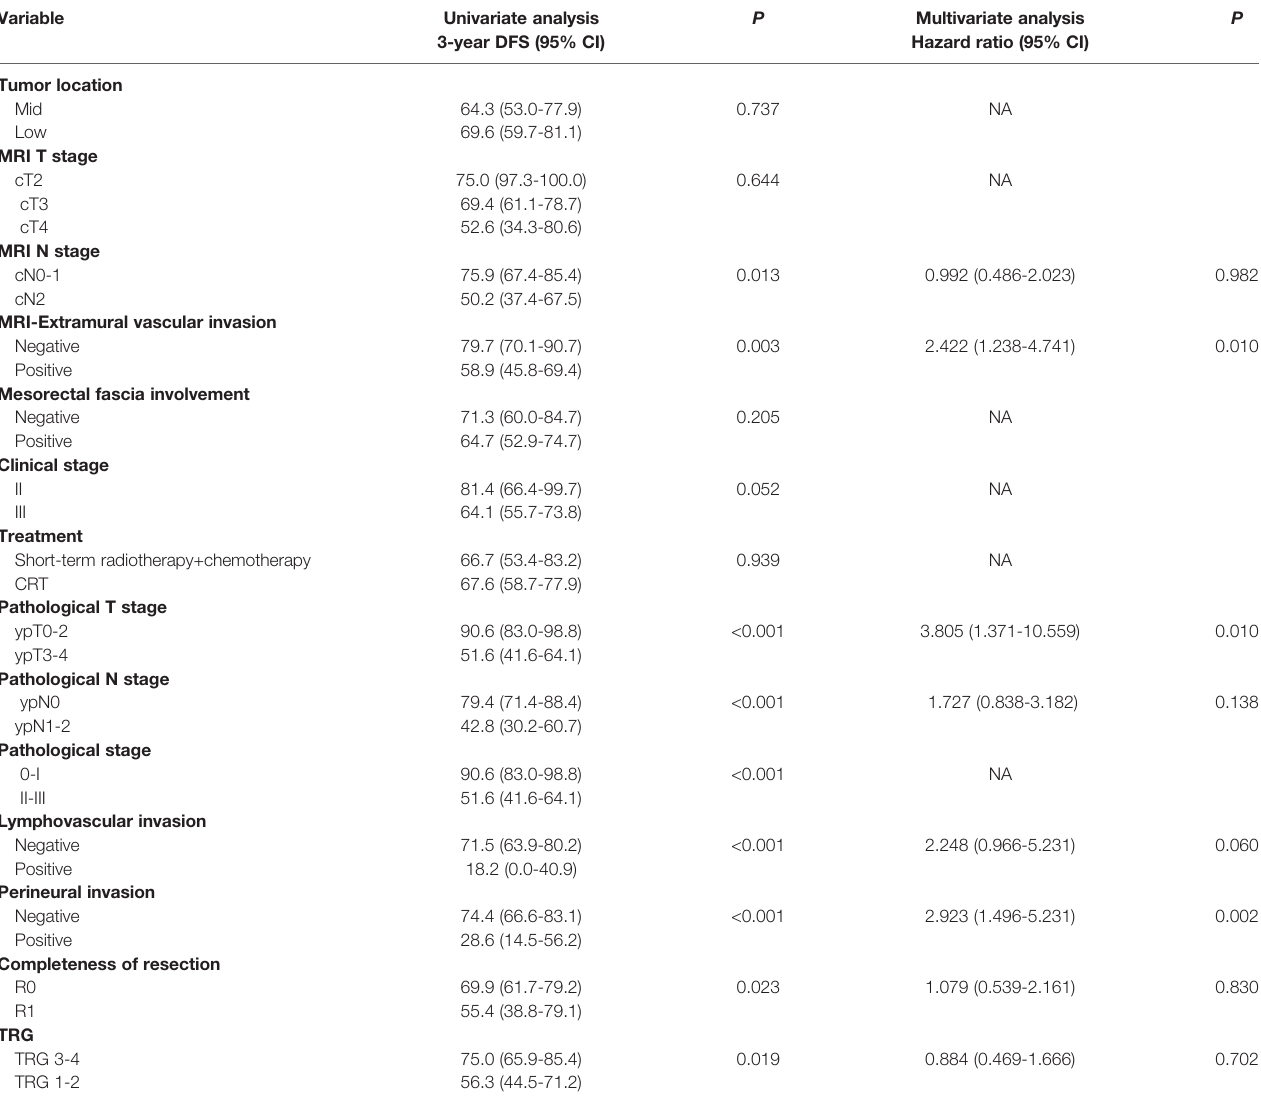
TABLE 2 | Univariate and multivariate analyses of DFS by pretreatment MRI and pathological factors based on the training cohort.